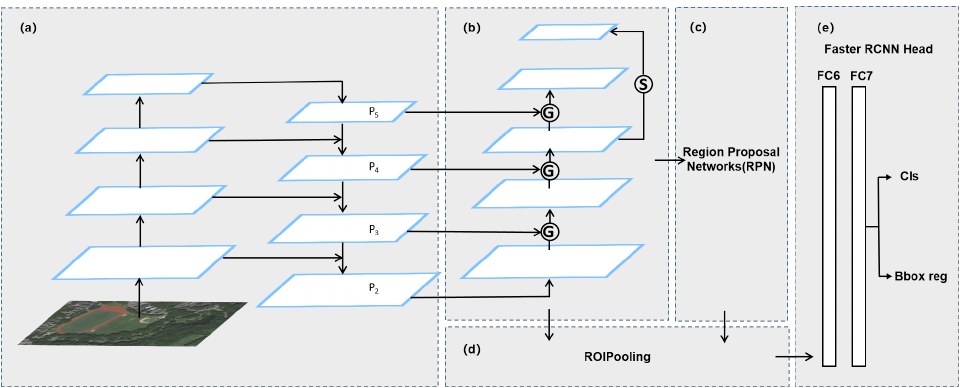
Figure 2. The overall pipeline of the proposed GPANet. ( a ) FPN feature extractor, ( b ) bottom-up gated connection, ( c ) regional proposal network (RPN), ( d ) ROIPooling and ( e ) Faster RCNN head.